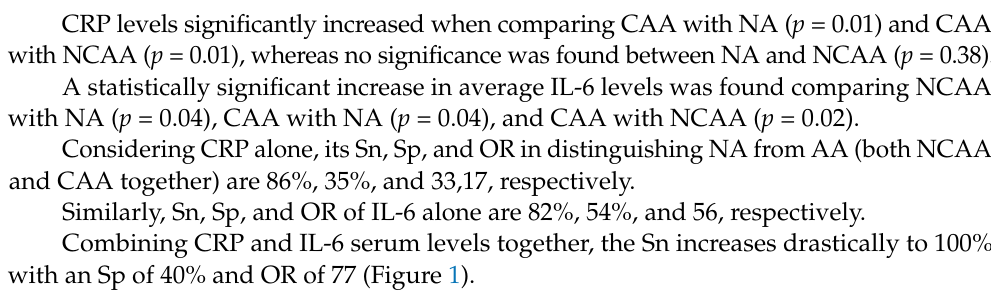
Table 1. Mean values, standard deviation (SD) and p -value of white blood cells (WBC), neutrophils (Neu), aPTT, INR, fibrinogen (Fib), ferritin (Fn), C-reactive protein (CRP), and Interleukine-6 (IL-6). NA = Not inflamed appendix. NCAA = not complicated acute appendicitis. CAA = complicated acute appendicitis. * = Statistically significant values.